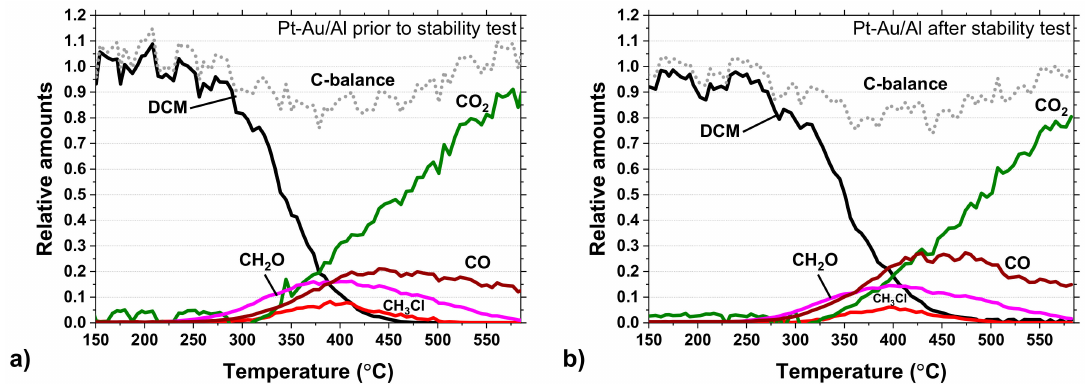
Figure 11. Carbon balance in DCM oxidation over the Pt-Au / Al catalyst ( a ) prior to and ( b ) after the stability test (same conditions as in Figure